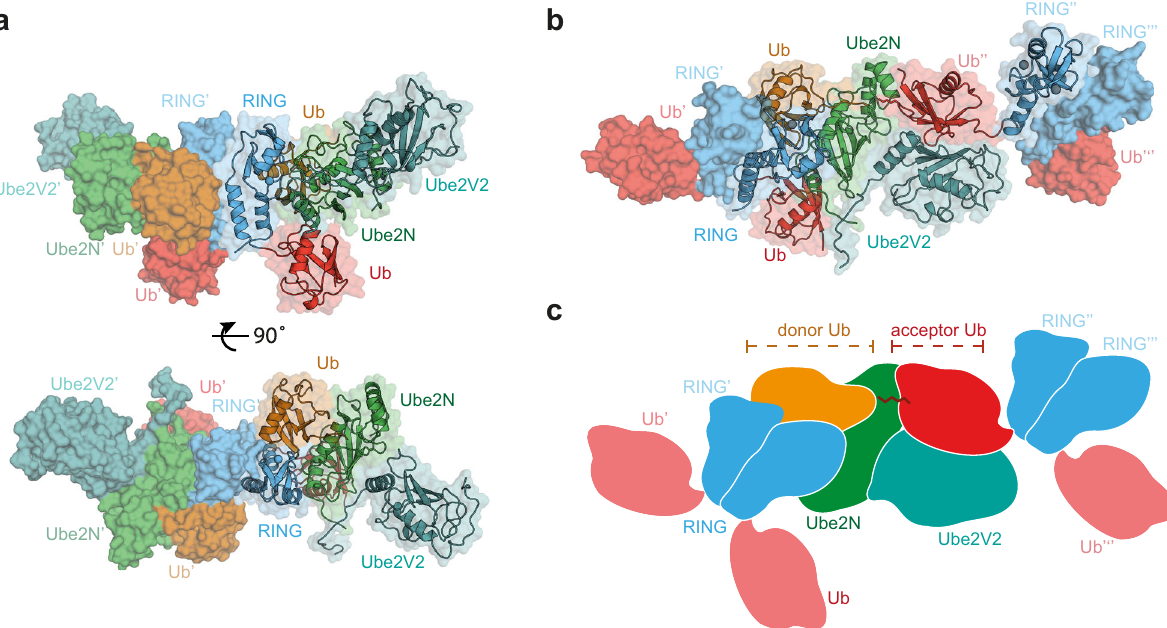
Fig. 1 Structure of initiation of RING-anchored ubiquitin chain elongation. a Side and top view of the Ub-R:Ube2N~Ub:Ube2V2 structure (Ub-R, Ub in red, R in blue, Ube2N~Ub, Ube2N in green, Ub in orange, and Ube2V2 in teal). Chains drawn as cartoon represent the asymmetric unit. b The canonical model of initiation of RING-anchored ubiquitin chain elongation. c Schematic cartoon, representing the canonical model of RING-anchored ubiquitin chain elongation shown in b . Symmetry mates are denoted by ′ next to the label. Ub ubiquitin, Ub-R